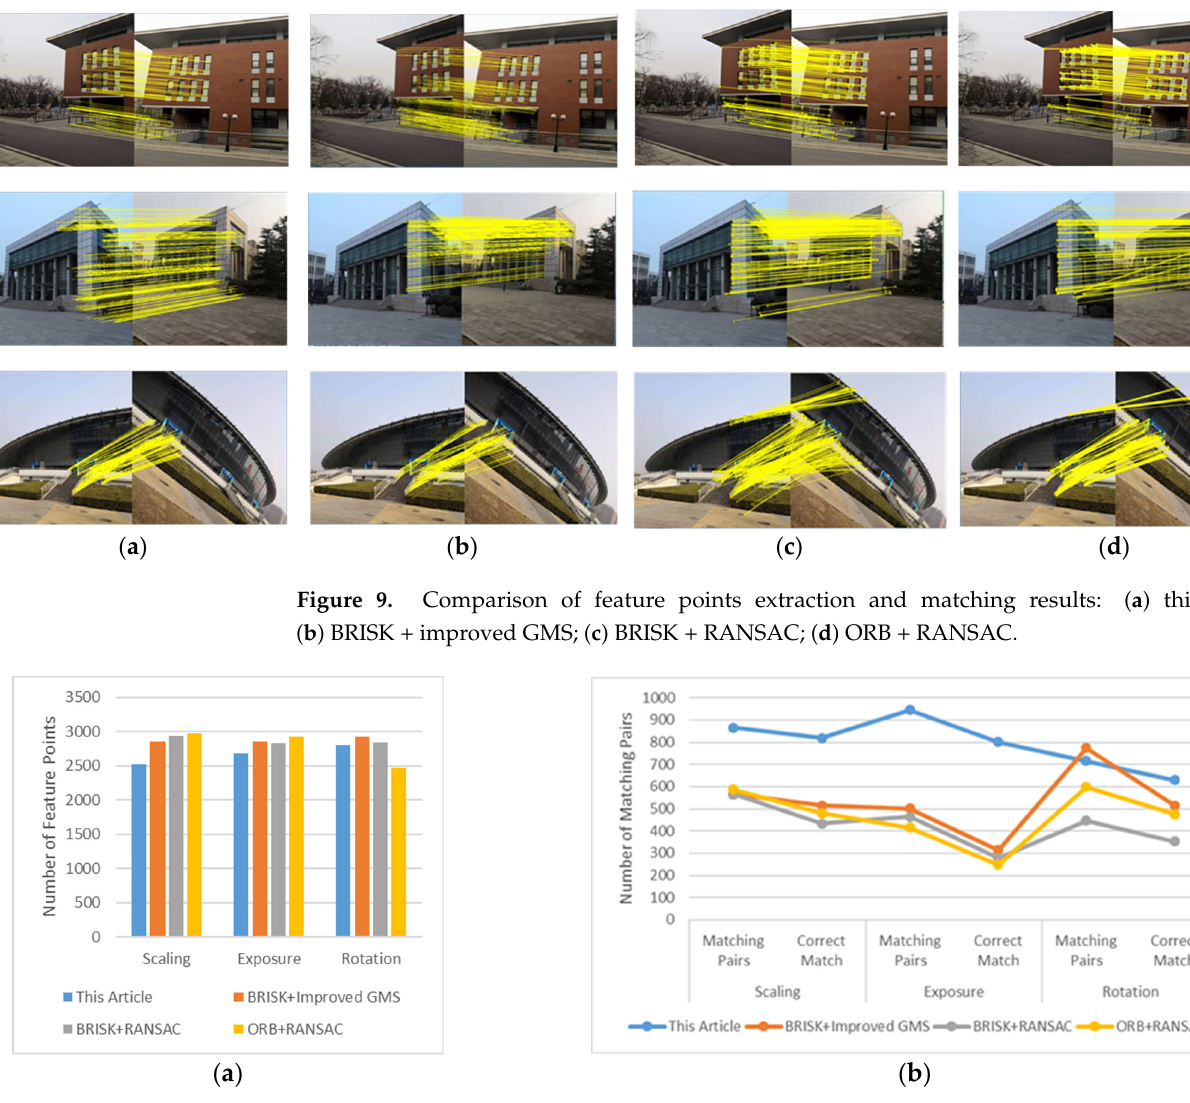
Figure 10. Comparison of feature point detection and matching results: ( a ) feature point extraction quantity; ( b ) the number of matching and correct matching pairs for each algorithm.